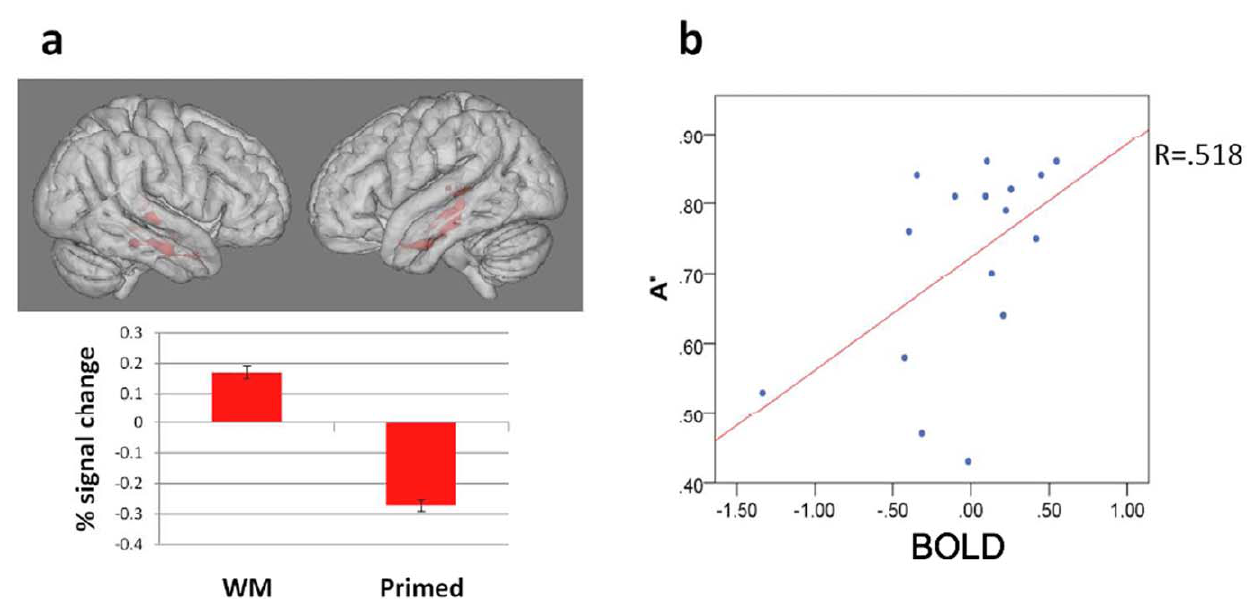
Figure 4. Data from Experiment 1. (A) Percentage signal change in MTL (paired repeats relative to the unpaired baseline) in WM and Primed conditions. Z=2.3, p , .05, corrected for multiple comparisons. (B) Scatterplot of relationship between BOLD signal during WM paired repetition blocks and memory sensitivity during WM item trials in the subsequent recognition test.